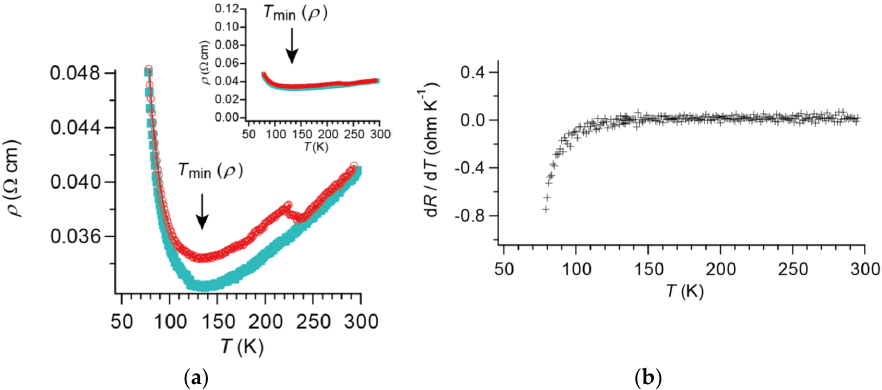
Figure A1. Temperature dependence of electrical resistivity of α -STF 2 I 3 . The samples in Figure A1 a , b are different from those in Figure 3a,b: ( a ) Enlarged view (~80–300 K). Red; heating-process data, blue; cooling-process data. (Inset) A different plot of the same data for comparison with Figure 3b. Since there are deviations in the data during the measurement, T min ( ρ ) is determined based on the first derivative of resistivity by temperature; ( b ) First derivative of resistivity by temperature; enlarged view (~80–300 K).